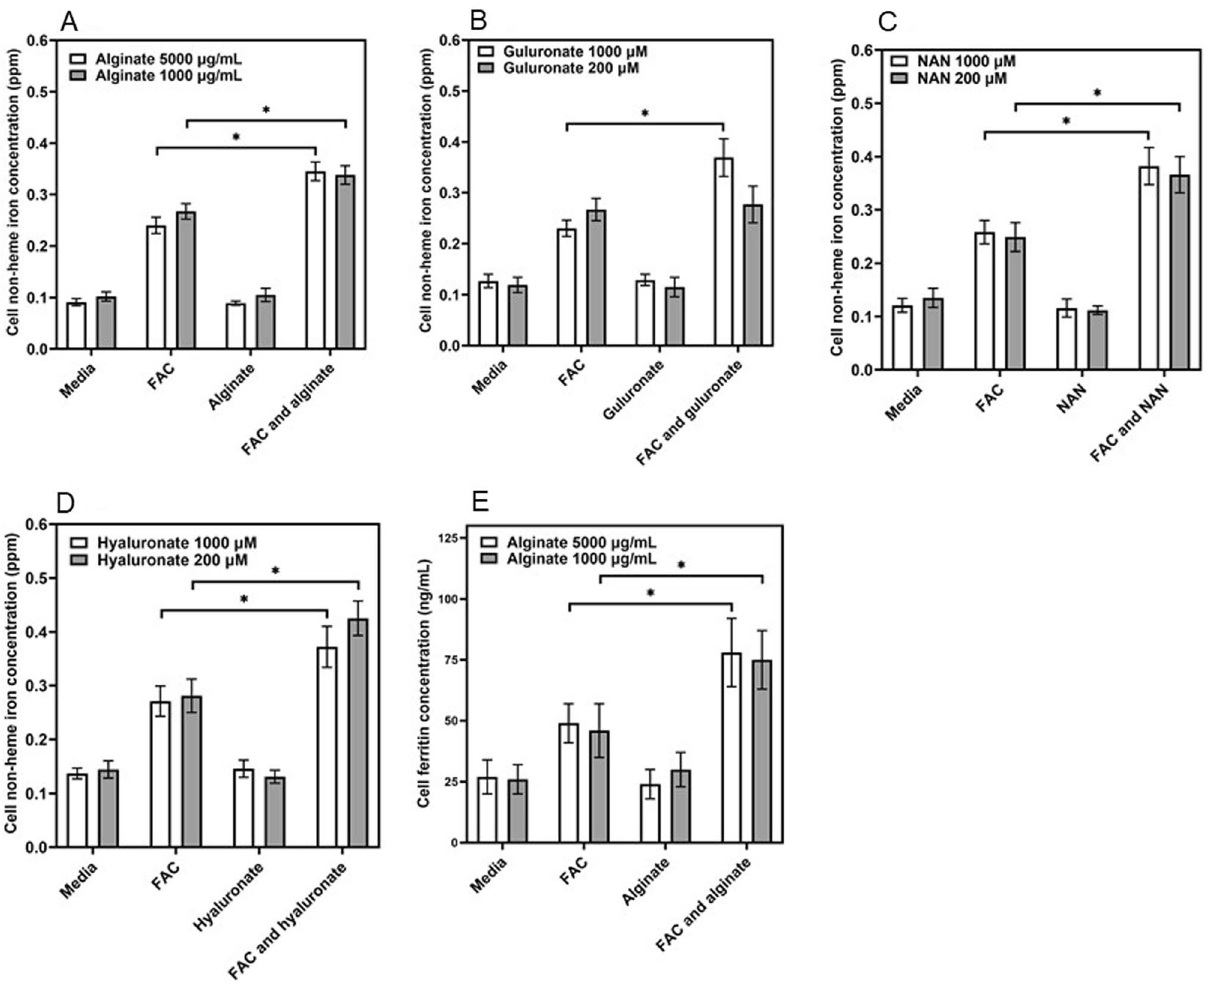
Figure 6. Cell iron and ferritin concentrations after exposures to NAN, alginate, guluronate, and hyaluronate. With inclusion of NAN, alginate, guluronate, and hyaluronate ( A – D respectively), concentrations of iron in BEAS-2B cells significantly increased at 4 h levels greater than those observed with FAC alone. Relative to iron alone, cell ferritin in BEAS-2B cells was increased at 24 h with inclusion of alginate ( E ). One way ANOVA was employed. *Increased relative to FAC (p <